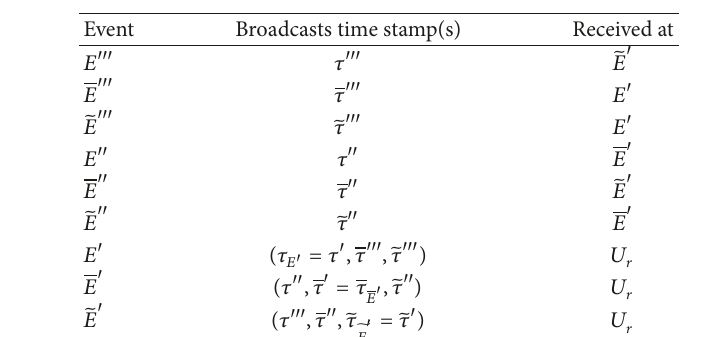
Table 3: The events and their broadcast time